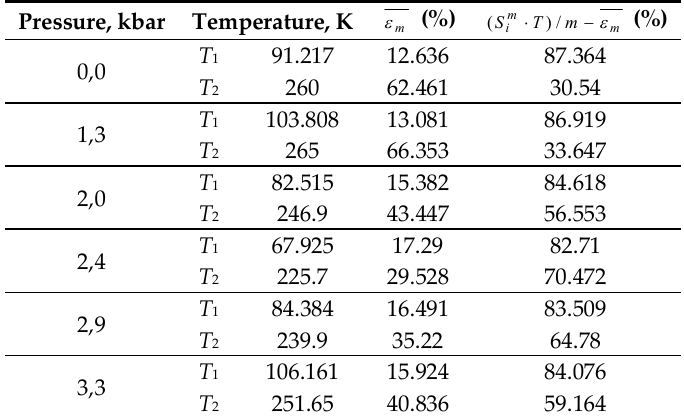
Table 7. Comparison of the average energy of the elementary activation act and its uncertainty for various hydrostatic pressures applied to the